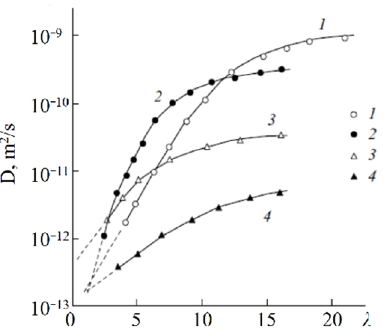
Figure 37. Self-diffusion coefficient dependences on the diffusant content of water (1), methanol (2), ethanol (3), and propanol (4) in the Li + -form of the perfluorinated membrane MF-4SC, λ is the number of diffusant molecules per sulfonate group (Adapted from [45]).